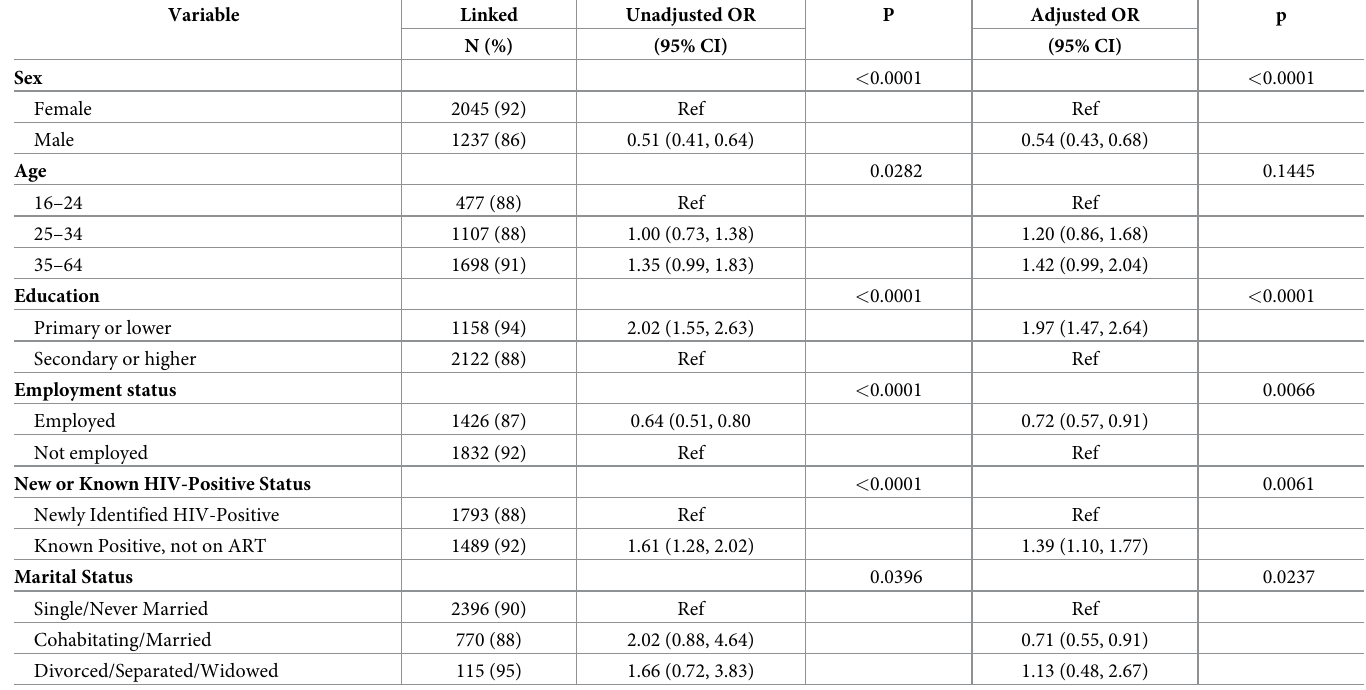
Table 2. Univariate and multivariate analyses of the association of sociodemographic variables with linkage to